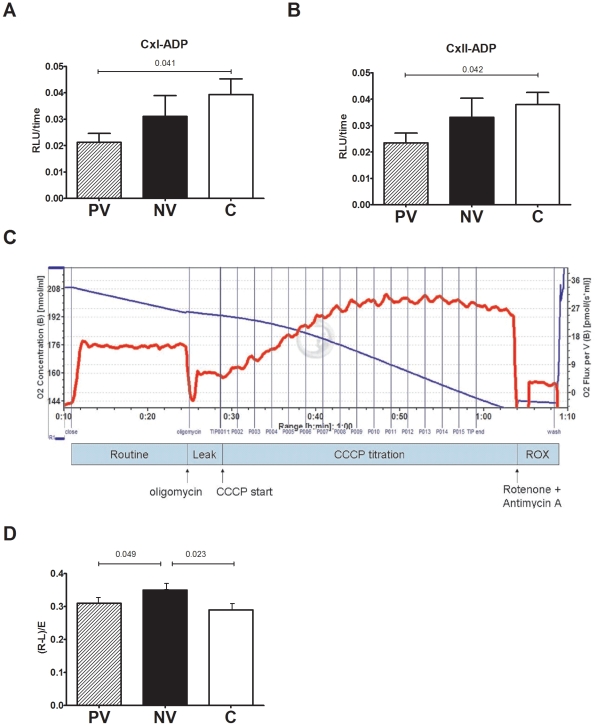
Reduced ATP production and endogenous respiration in poor vision ADOA patients.The rate of mitochondrial ATP synthesis was determined in cells treated with 50 ug/ml digitonin. ATP synthesis driven by A) complex I (glutamate plus malate) or B) complex II (succinate plus rotenone) substrates was determined. This shows a significant decrease in complex I and II driven ATP production in poor vision, but not normal vision ADOA compared to controls. C) An example trace showing respiration of intact cells on endogenous substrates (routine), leak (oligomycin inhibited), maximum electron transport capacity (CCCP titration) and residual oxygen consumption (ROX). D) Cell respiration in vivo at intracellular, non-saturating ADP levels showed normal vision ADOA cells have a higher routine respiration rate.